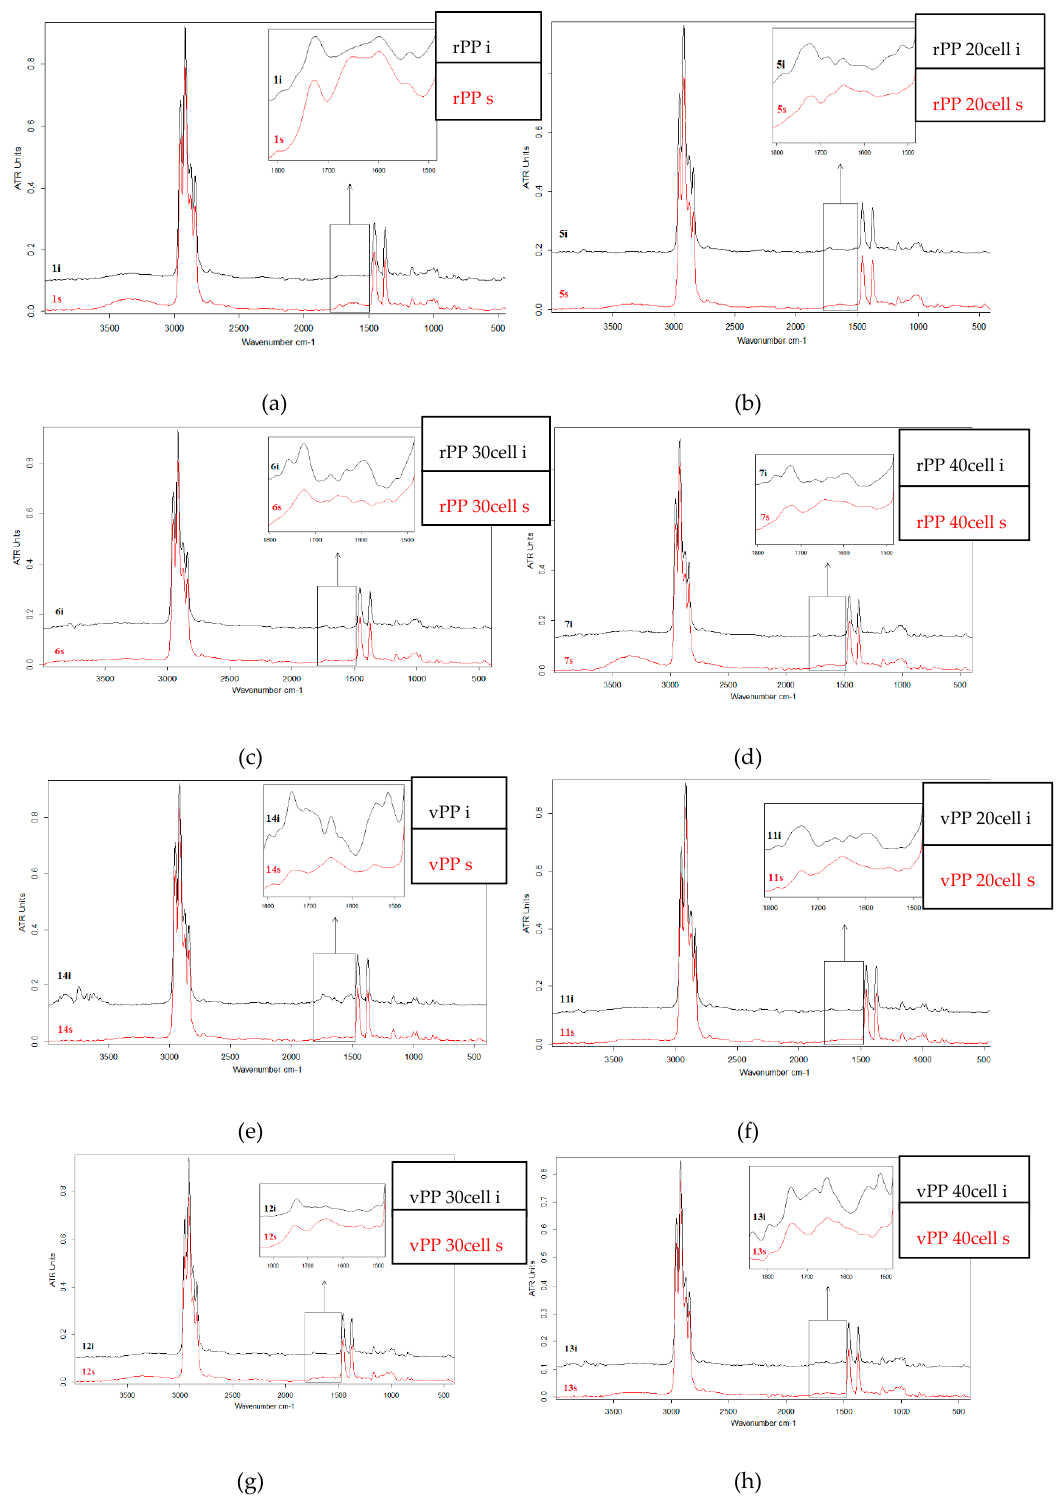
Figure 5. Fourier transform infra-red spectroscopy with attenuated total reflectance (FTIR-ATR) spectra of vPP and rPP-cellulose composites before and after soil burial (i = initial sample; s = soil buried sample). ( a ) rPP before and after soil burial; ( b ) rPP 20cell before and after soil burial; ( c ) rPP 30cell before and after soil burial; ( d ) rPP 40cell before and after soil burial; ( e ) vPP before and after soil burial; ( f ) vPP 20cell before and after soil burial; ( g ) vPP 30cell before and after soil burial; ( h ) vPP 40cell before and after soil